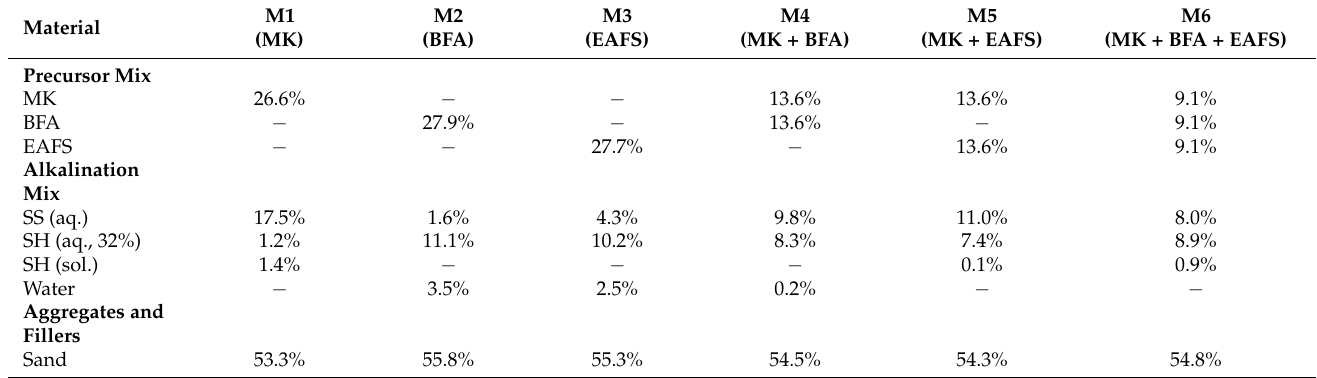
Table 5. Used GPC mortar formulations, expressed as mass fractions of each